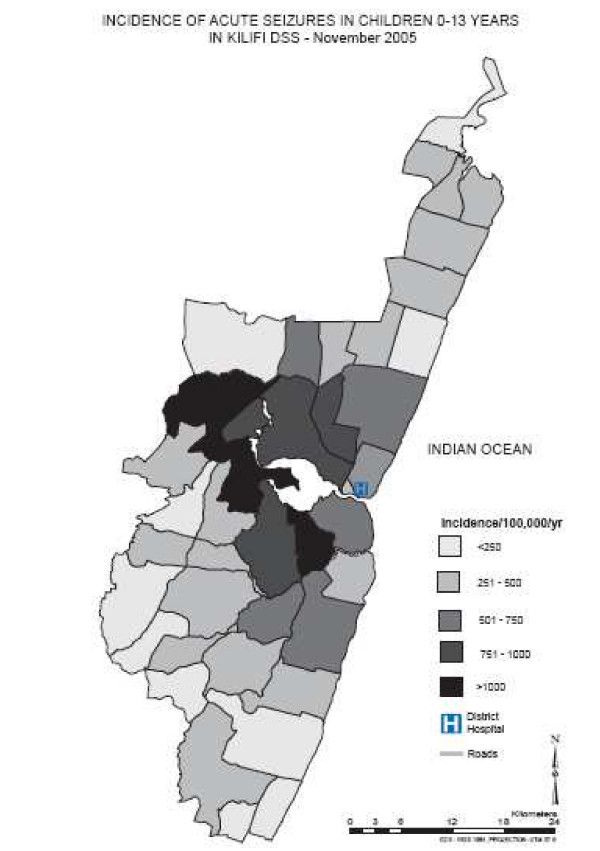
Incidence of acute seizures in Kilifi study area. Figure 3 is a map of Kilifi demographic surveillance area and it shows the incidence for acute seizures in the study area by sub-location. In general, the incidence is highest in areas nearest to the district hospital and decreases with distance away from the hospital.